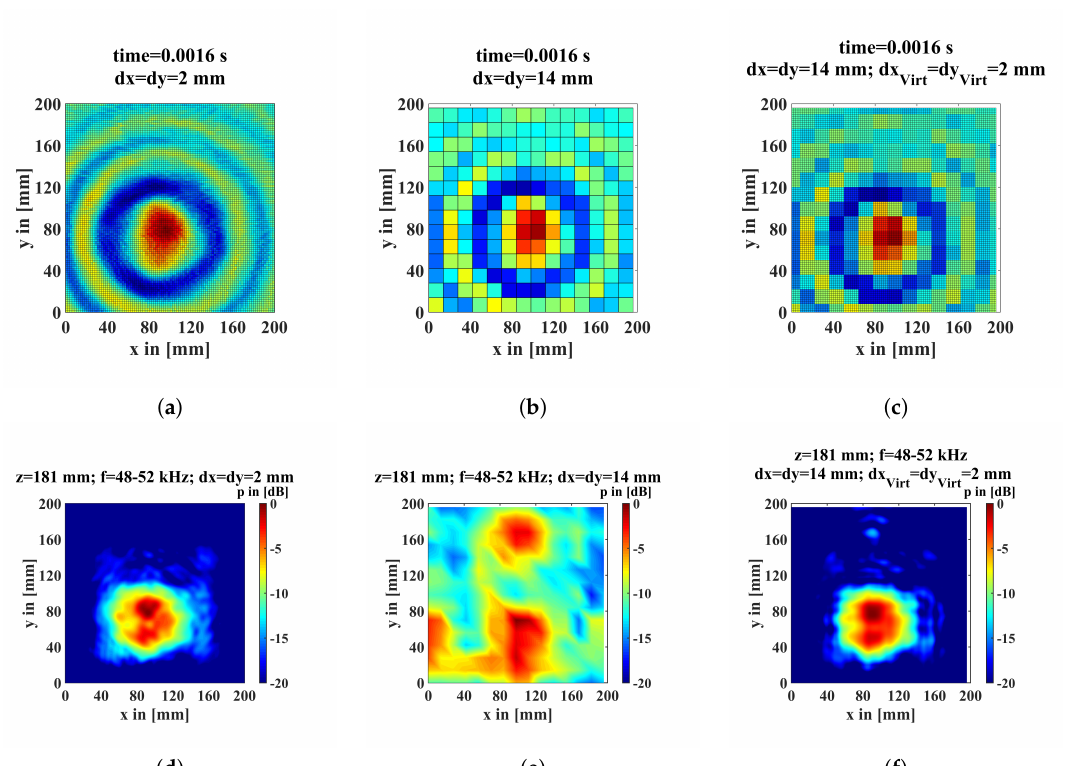
Figure 9. The upper row depicts snapshots of the time data in the measuring plane with different measuring grid point distances. ( a ) “Default” measuring grid with d x = d y = 2 mm. ( b ) The coarse measuring grid with a grid point distance of d x = d y = 14 mm; ( c ) the data from ( b ) refined with the interpolation method “nearest” to a measuring grid d x Virt = d y Virt = 2 mm. The lower row depicts the back propagated amplitude distribution at the top of the particleboard. ( d ) “default” measuring grid with d x = d y = 2 mm. ( e ) The coarse measuring grid with a grid point distance of d x = d y = 14 mm and ( f ) refined with the interpolation method “nearest” to a measuring grid d x Virt = d y Virt = 2